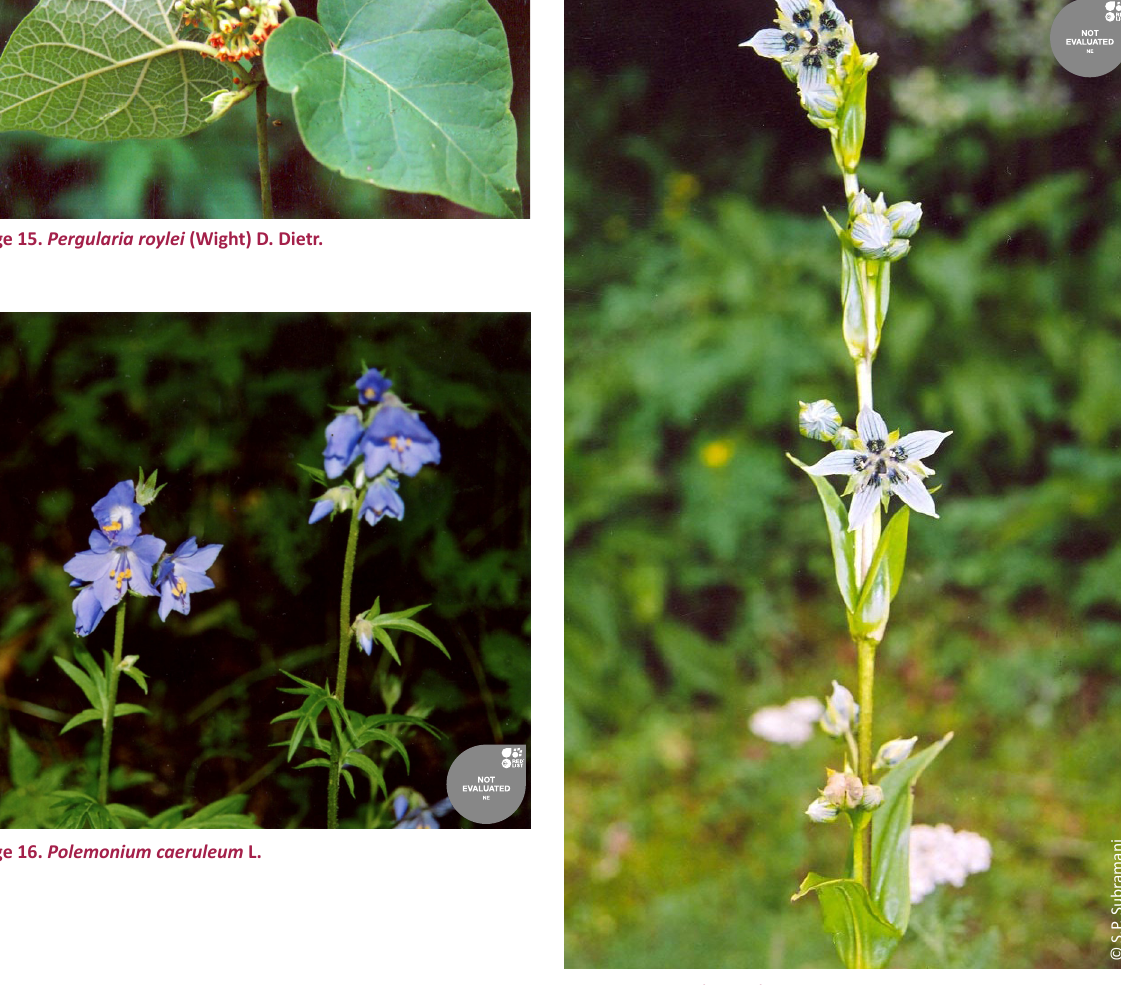
Image 17. Swertia speciosa